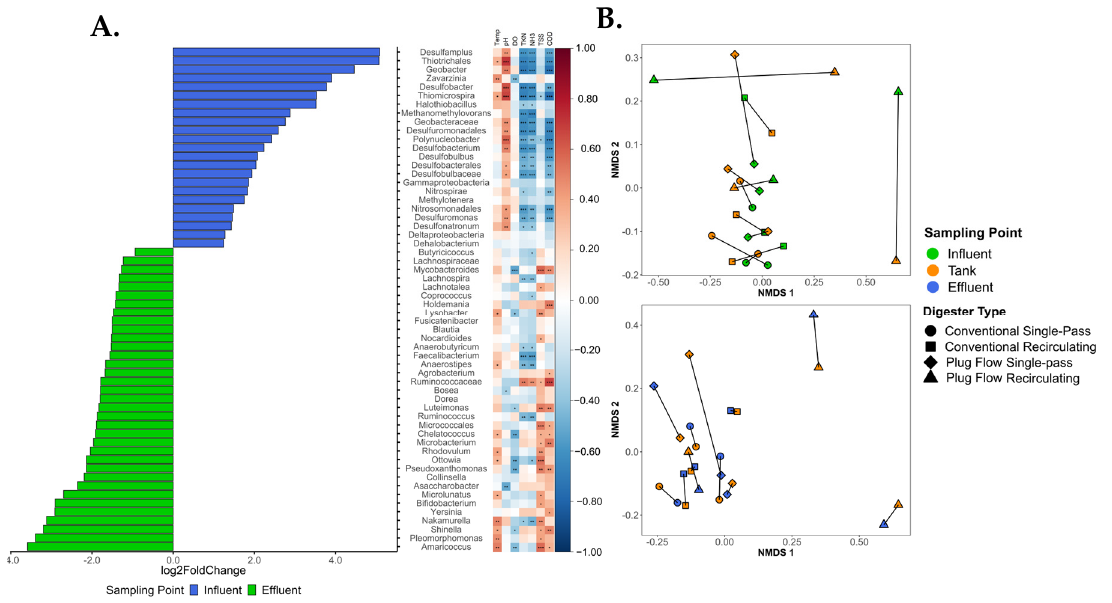
Figure 5. ( A ) Pairwise comparisons of differentially abundant genera between and Spearman rank correlations of influent and effluent sewage. Differential abundance analysis was determined using DESeq2 with an abundance cutoff at 0.01% of total agglomerated genera counts and an adjusted p -value cutoff at p < 0.05. Significant correlations are marked with asterisks ( p < 0.05), where "***" 0.001, "**" 0.01, "*" 0.05. ( B ) Procrustes NMDS ordination influent vs. tank and tank vs. effluent comparisons. Significance test of the M2 procrustes statistic was performed by the R vegan function "protest" ( p < 0.05).